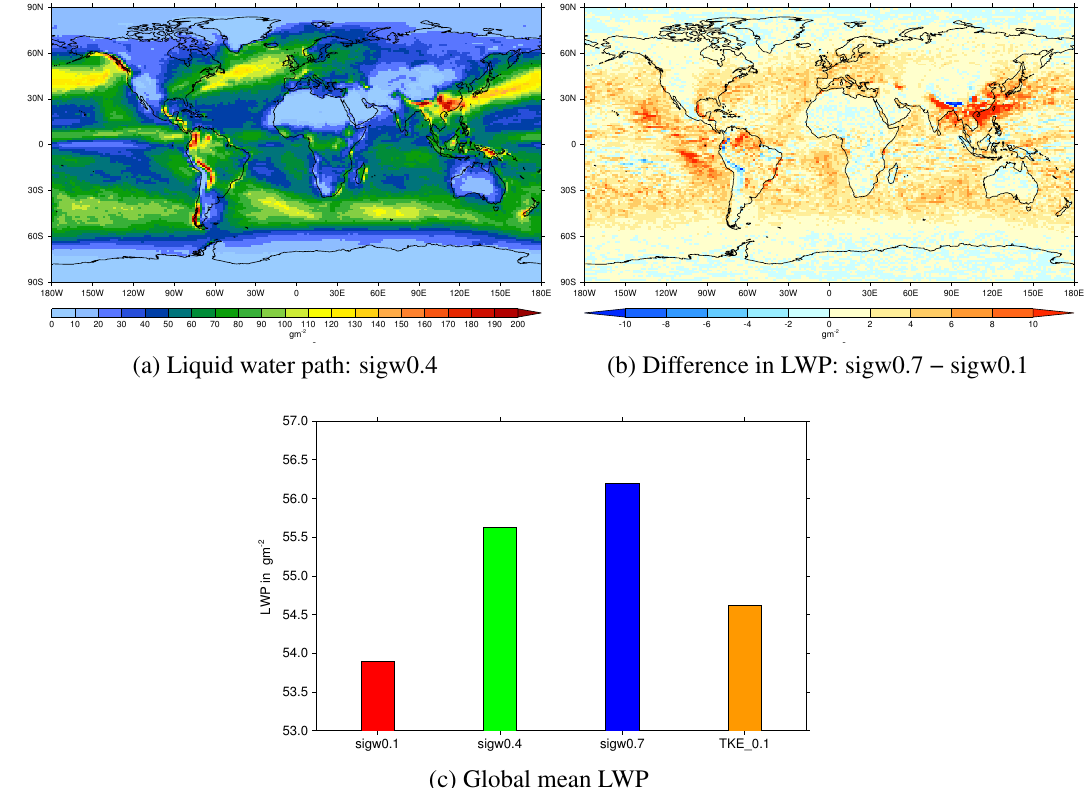
Figure 3. (a) Annual mean liquid water path in model run sigw0.4 (AWM = 55.63gm − 2 ), (b) difference in annual mean LWP between Fig. 3 : (a) Annual mean liquid water path in model run sigw0.4 (AWM=55.63 g m -2 ), (b) model runs sigw0.7 and sigw0.1 (AWM = 2.28gm − 2 ), and (c) global mean LWP for each model configuration (note vertical axis shown difference in annual mean LWP between model runs sigw0.7 and sigw0.1 (AWM=2.28 g m -2 ), from 53.0gm − 2 (c) global mean LWP for each model configuration (note vertical axis shown from 53 . 0gm − 2 upwards).